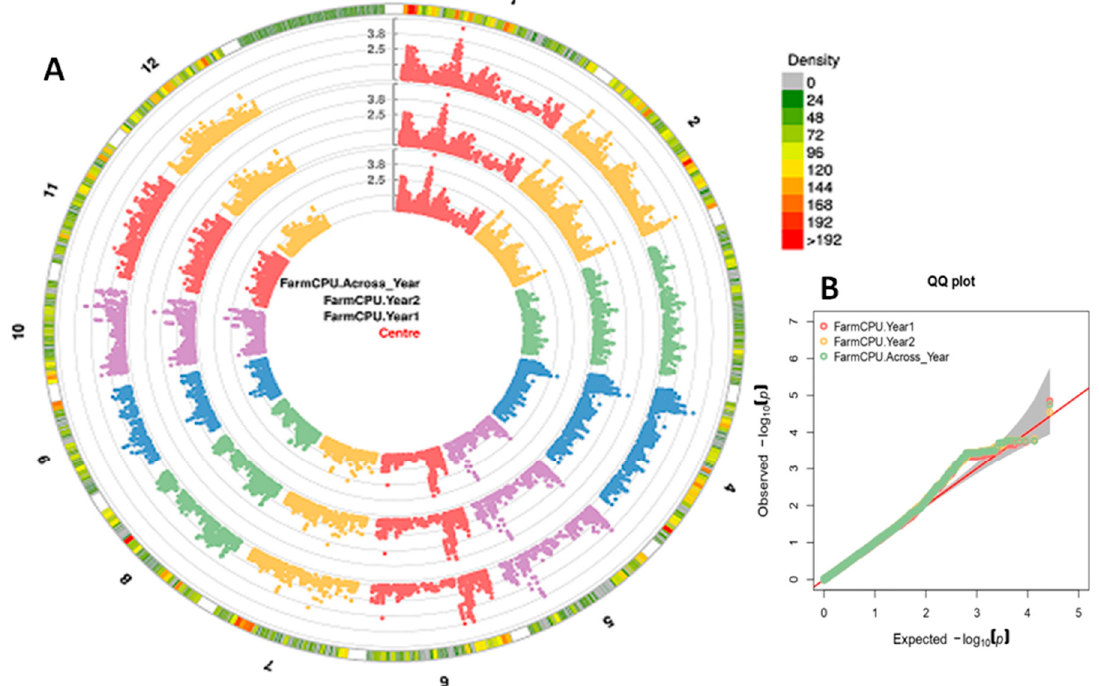
Figure 5. ( A ) Circular-Manhattan plot; ( B ) Quantile–quantile (QQ) plots of Farm CPU showing the